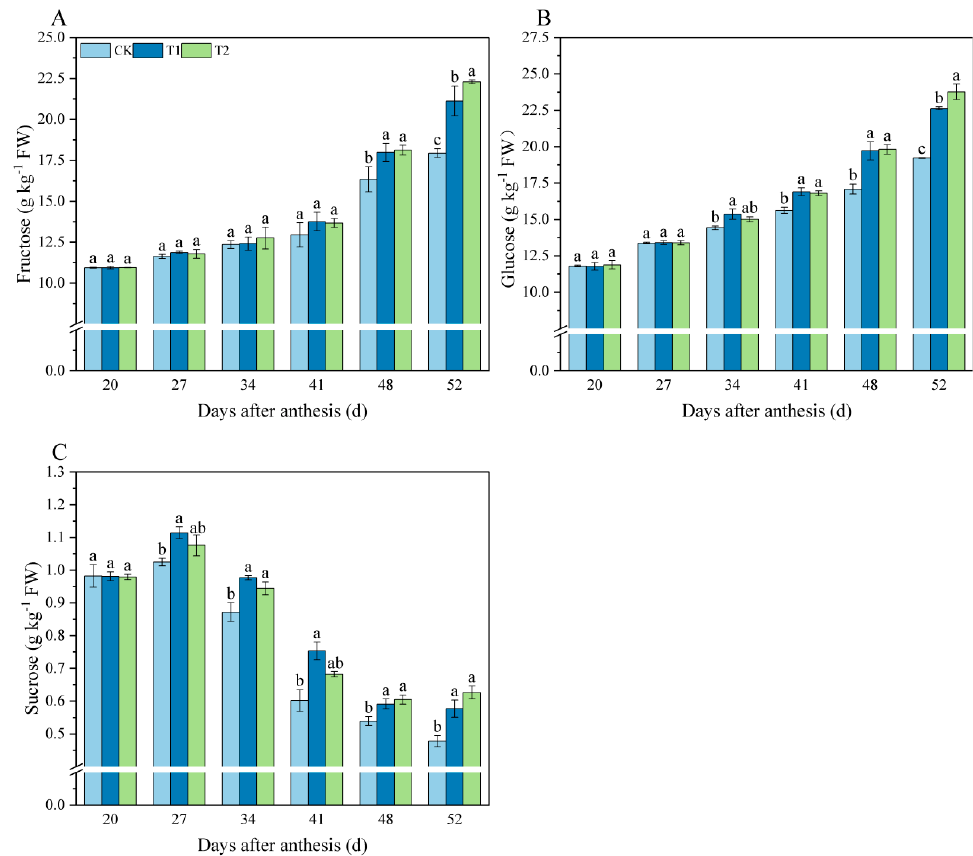
Figure 1. Effects of exogenous melatonin on sugar components content in tomato fruit. ( A ) Fructose. ( B ) Glucose. ( C ) Sucrose. Results are means ± SE of three independent replications. Different letters represent significant differences between treatments ( p <